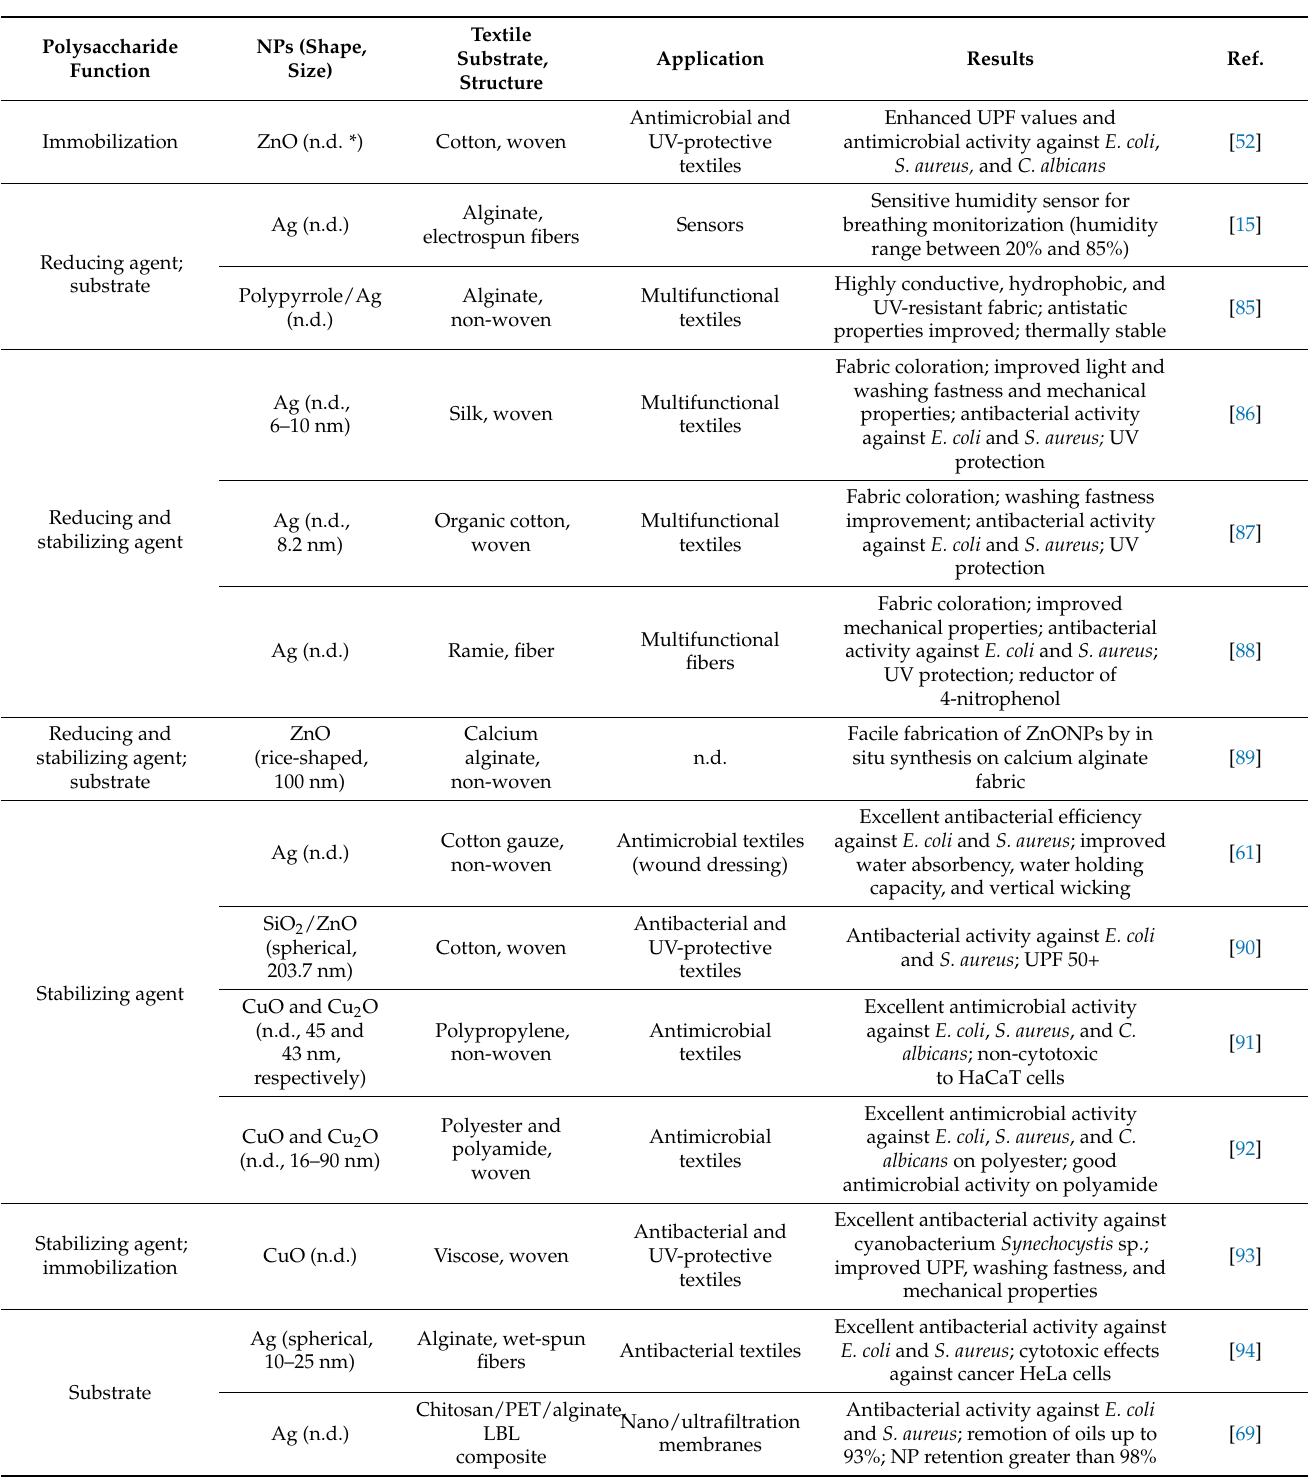
Table 2. Textile materials functionalized with alginate and metal nanoparticles. Polysaccharide function towards